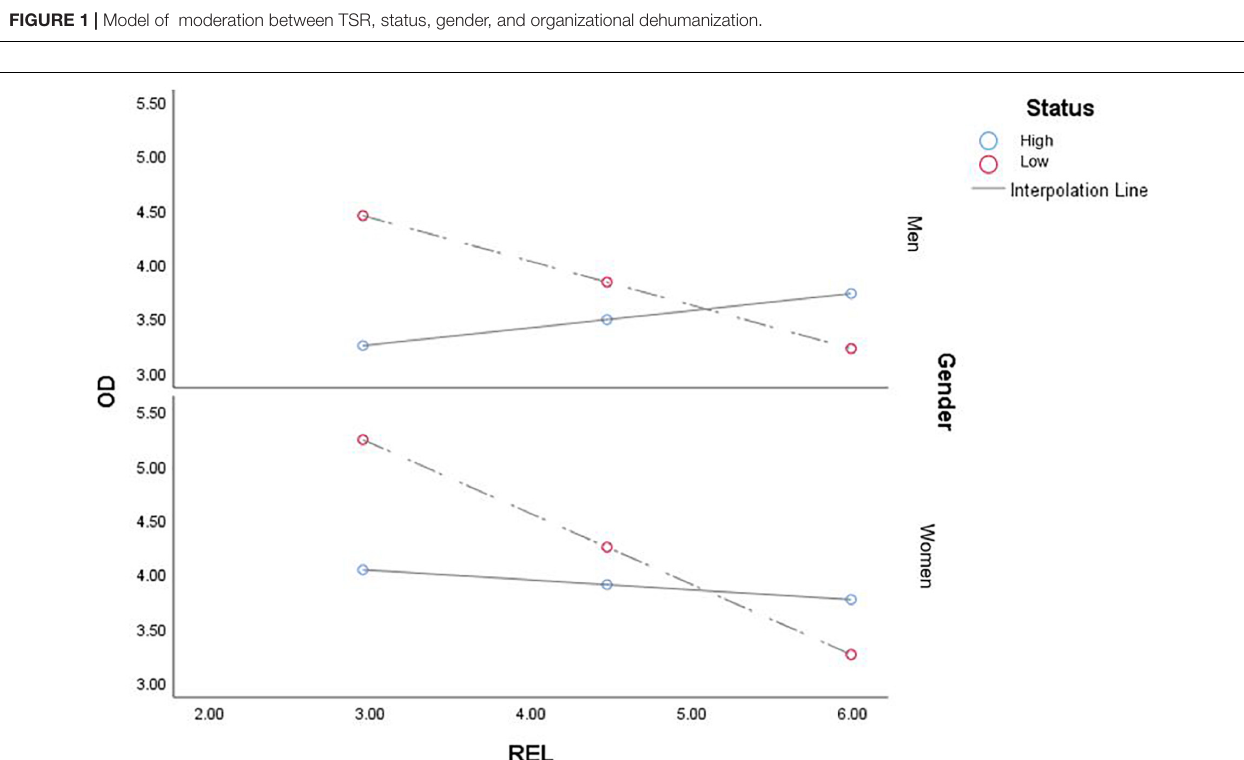
FIGURE 2 | Conditional effect that the relationship with the outgroup has on the perception of organizational dehumanization by gender and